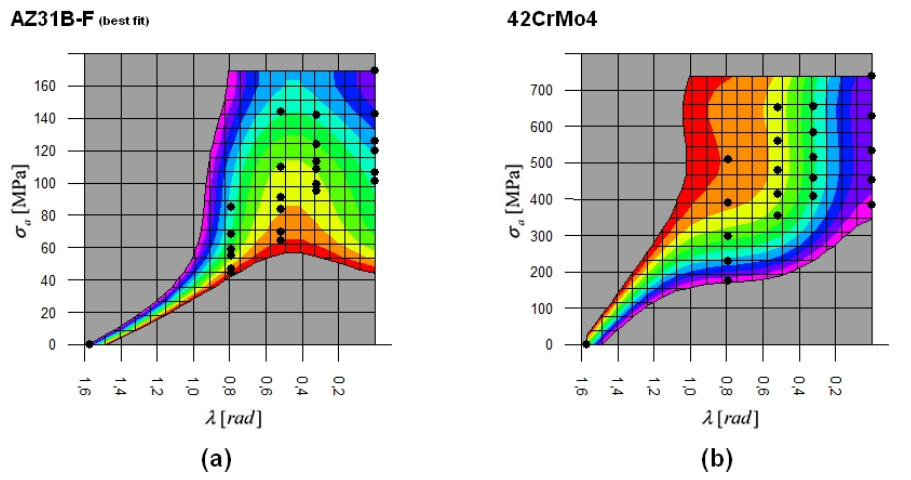
Figure 9. Normal stress vs. stress amplitude ratio, ( a ) AZ31B-F, ( b )